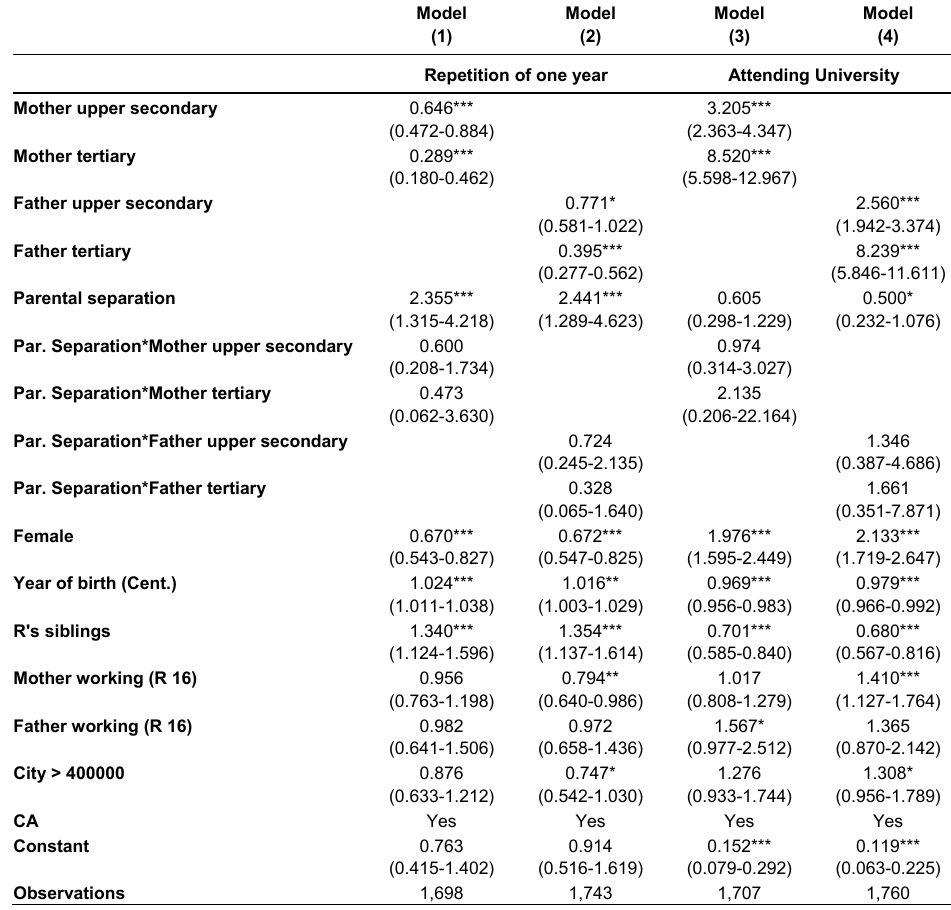
Table A.2 : Logit models of repeating one year at school and attending university after parental separation by mother and father education. Interaction